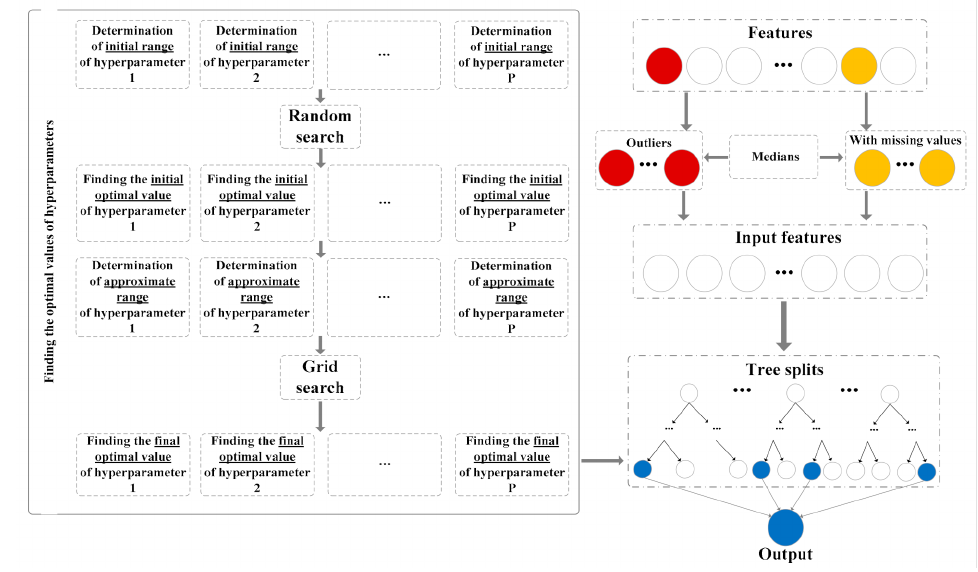
Figure 5. The flow chart of the experiments, conducted with the boosting ensemble learning models, enriched by the proposed RG hyperparameter optimization